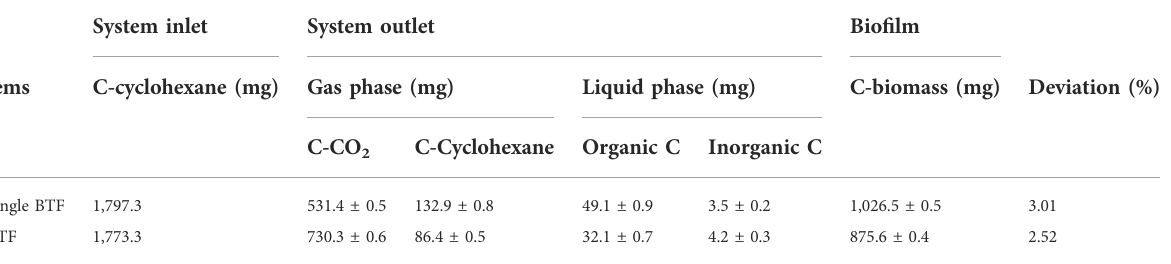
TABLE 1 Distribution of carbon in the single BTF and UV-BTF